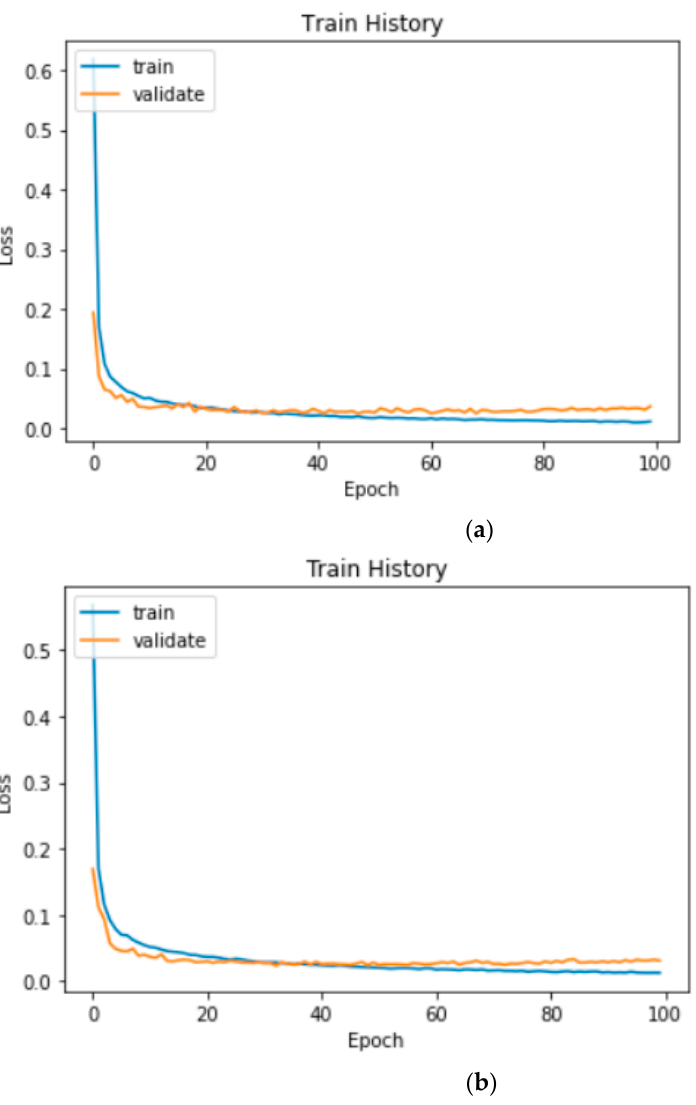
Figure 12. Loss curve of the proposed two-channel CNN–BiLSTM model: ( a ) run on the CPU and ( b ) run on the GPU.